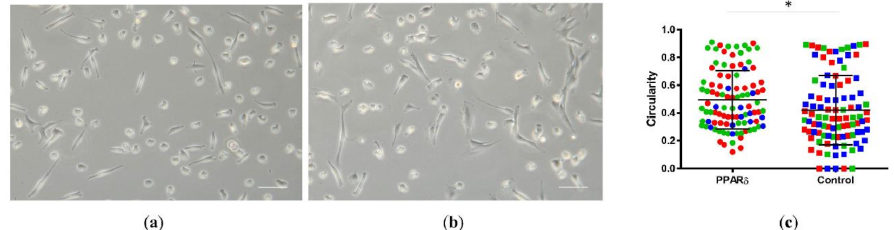
Figure 2. Light microscopy phase-contrast pictures of nucleus pulposus cells (NPCs) growth with PPAR δ agonist treatment ( a ) and control ( b ). Here, “Control” represents cells cultured within control media without PPAR δ agonist, “PPAR δ ” refers to cells cultured with PPAR δ agonist treatment. Scale bar = 100 µ m. The measure using ImageJ showed the cells’circularity ( c ). Each dot represents one cell ( n = 100), taken from three donors marked in red, green, and blue for both groups, respec- tively. Mann–Whitney U test p = 0.01 * = p -value < 0.05. Lines in ( c ) represent means ± standard deviation